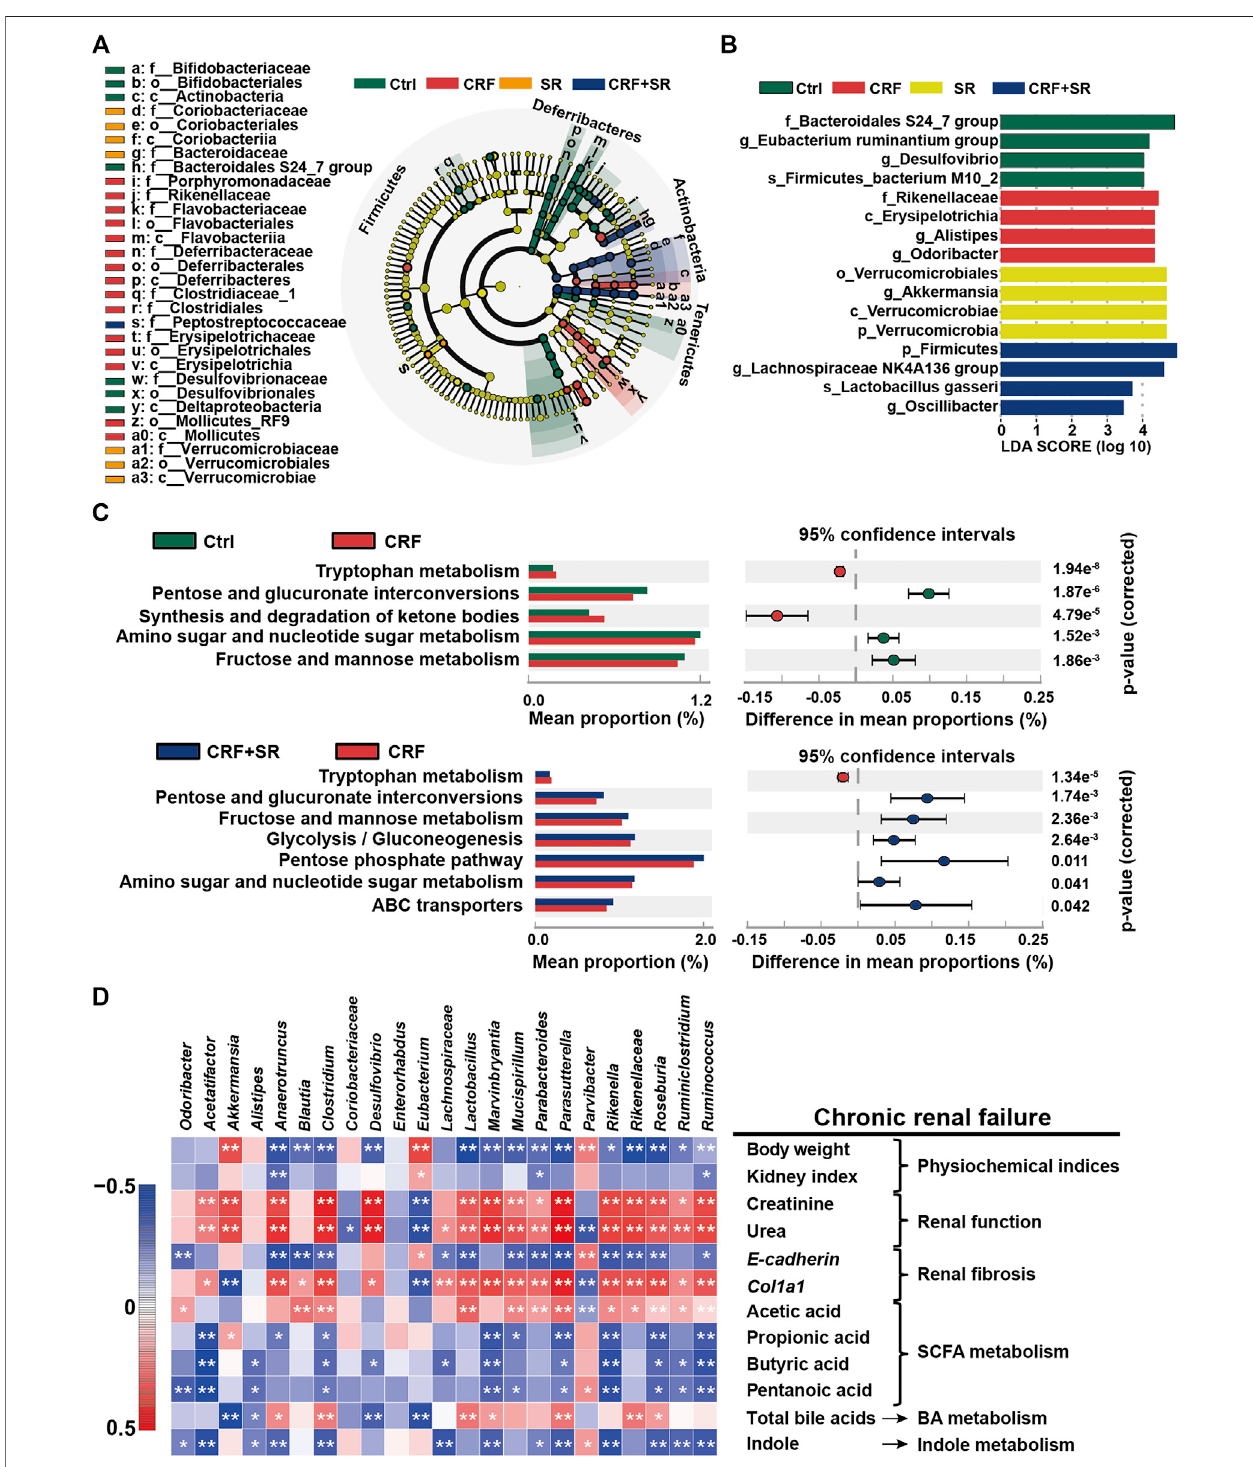
FIGURE 7 | Impact of SR decoction on characteristic taxa and bacterial metabolism in CRF mice, and correlation between gut microbiota dysbiosis and SRF occurrence. (A) Identi fi cation of characteristic taxa among four experimental groups by linear discriminant analysis (LDA) effect size (LEfSe). (B) Presentation of characteristictaxausingLDAwithathreshold score > 3.0.BarlengthofLDArepresents theimpact ofcharacteristictaxainindividualgroups. (C) Functionalpredictionof Kyoto Encyclopedia of Genes and Genomes (KEGG) pathways by Phylogenetic investigation of communities by reconstruction of unobserved states (PICRUSt) analysis. (D) Spearman ’ scorrelationanalysisbetweenphysiochemicalindexesand23generawiththegreatestchangesinabundanceamongfourexperimentalgroups. The colors ranged from blue (negative correlation) to dark red (positive correlation), and signi fi cant correlations (n = 7) were marked by * p < 0.05, ** p < 0.01.